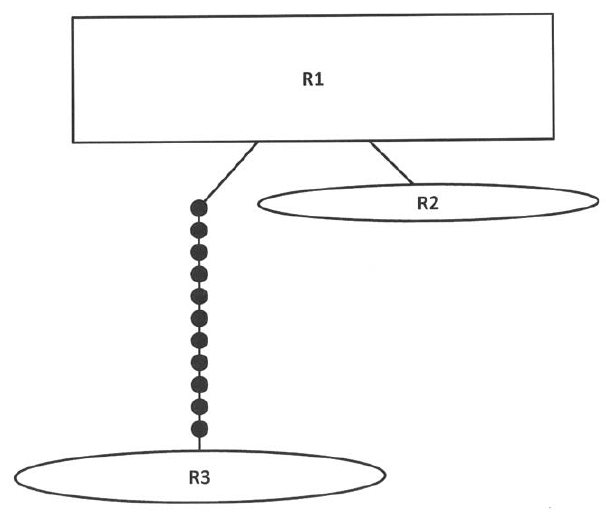
Figure 2. Statistical parsimony networks for 16S rDNA haplotypes of Bactrocera caudata . Lines represent parsimonous connections between haplotypes and the small circles indicate missing haplotype. The size of square or oval corresponds to the haplotype frequency.